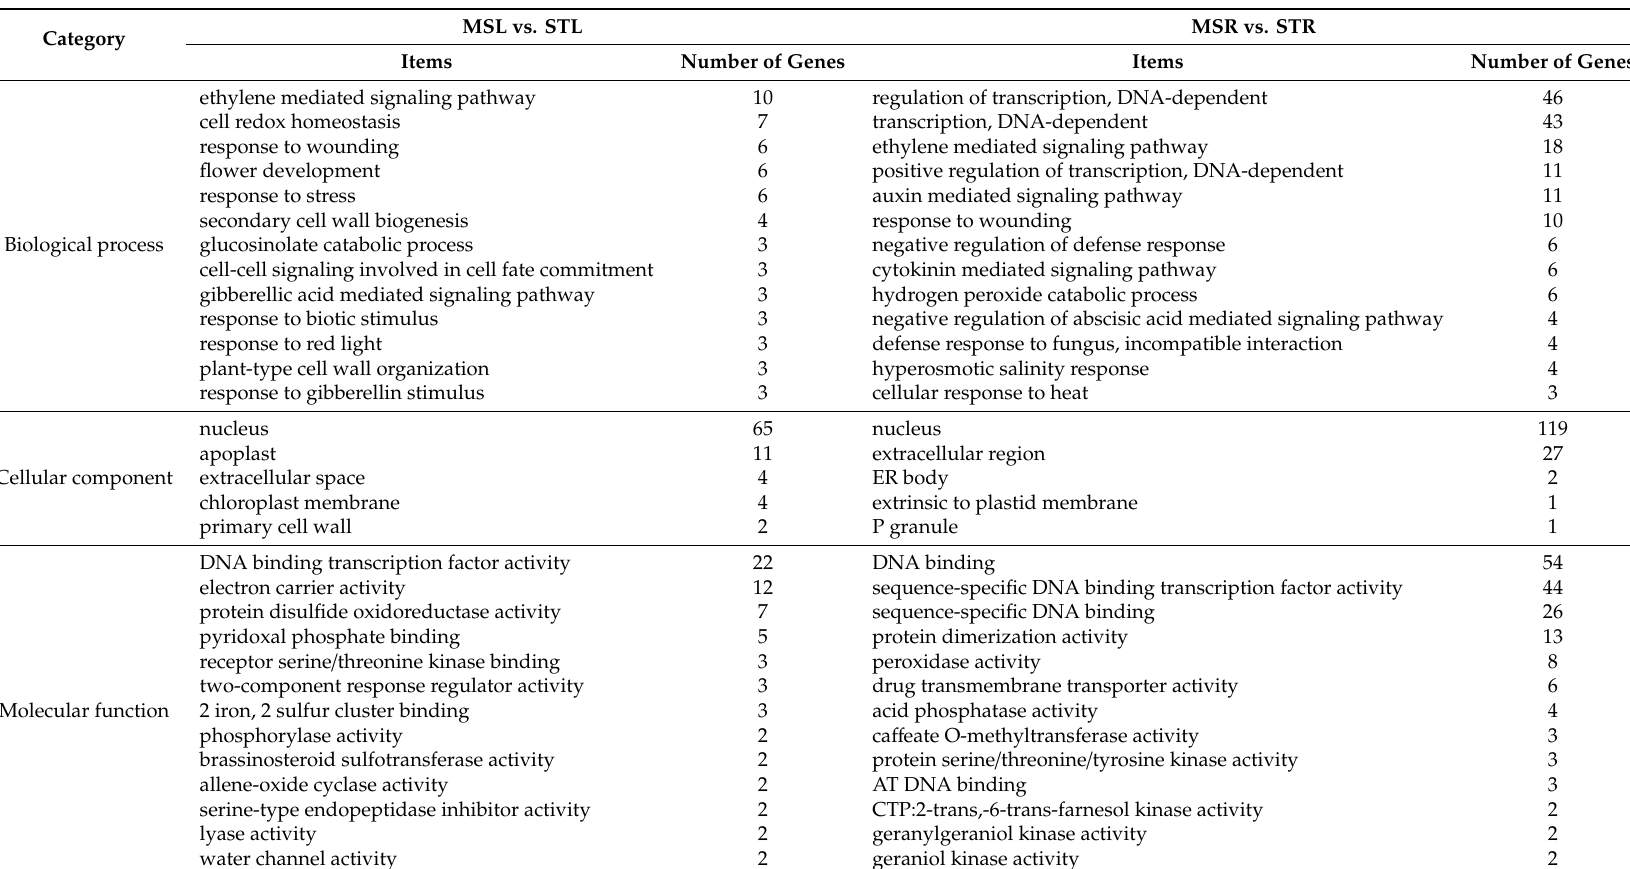
Table 2. Gene Ontology (GO) classifications of DEGs in the leaves and roots. The genes were divided into three main categories by GO analysis: Biological process, molecular function, and cellular component. Numbers indicate the regulated genes in the corresponding